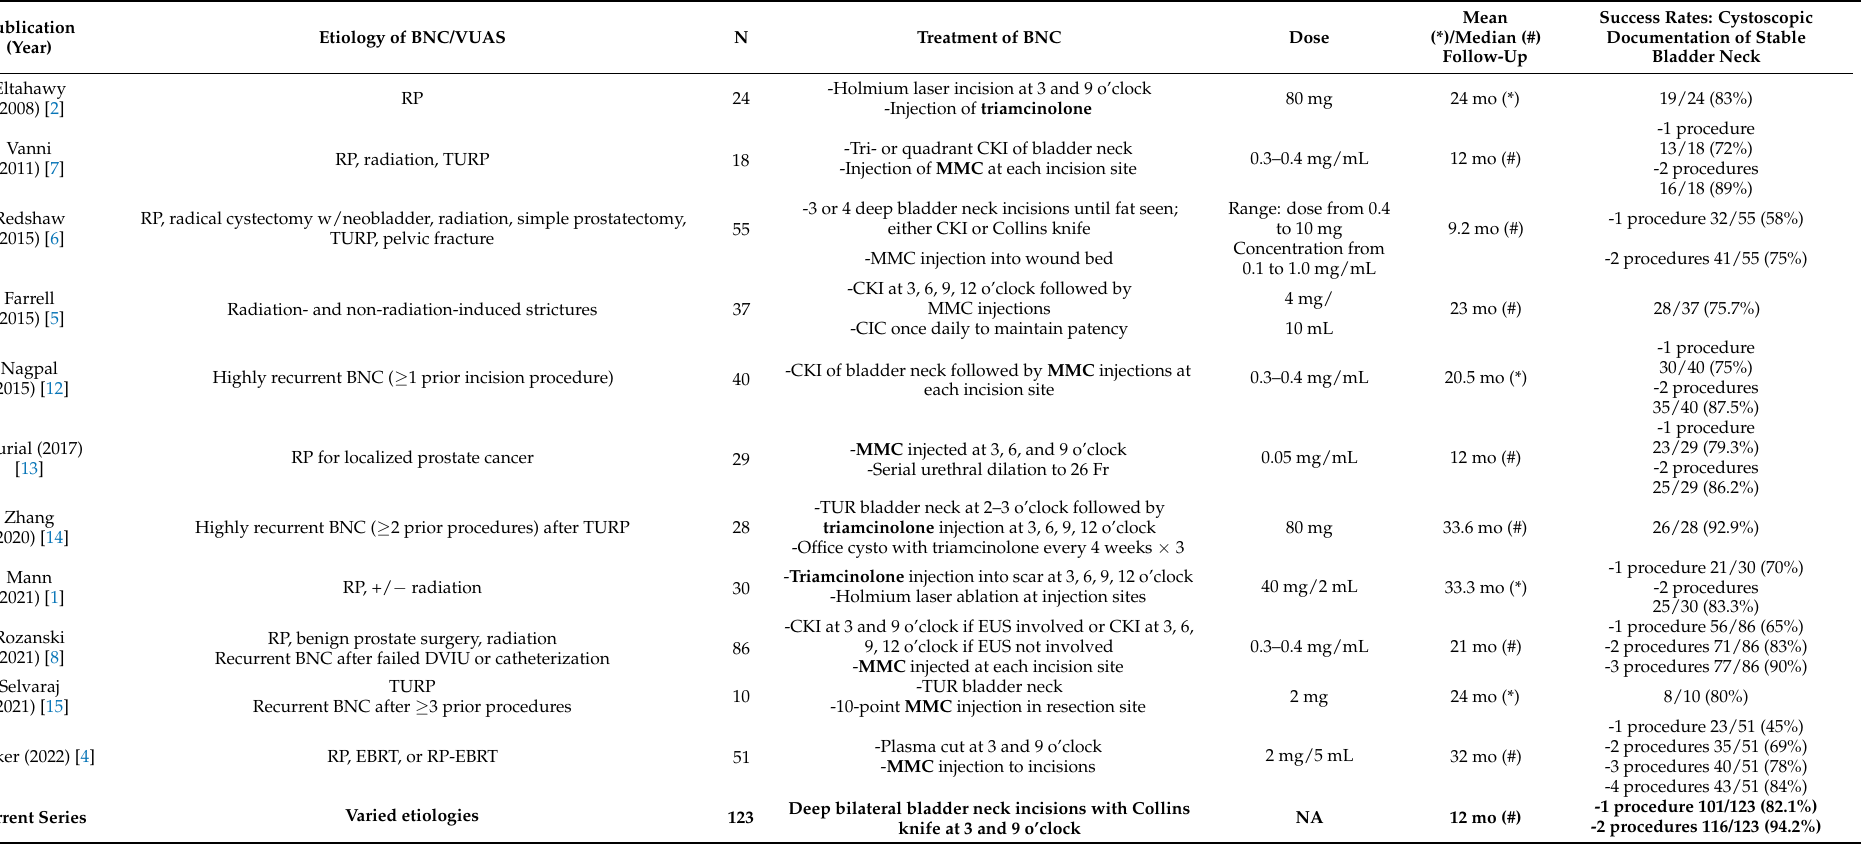
Table 3. Summary of studies utilizing endoscopic management of BNC/VUAS with adjunctive